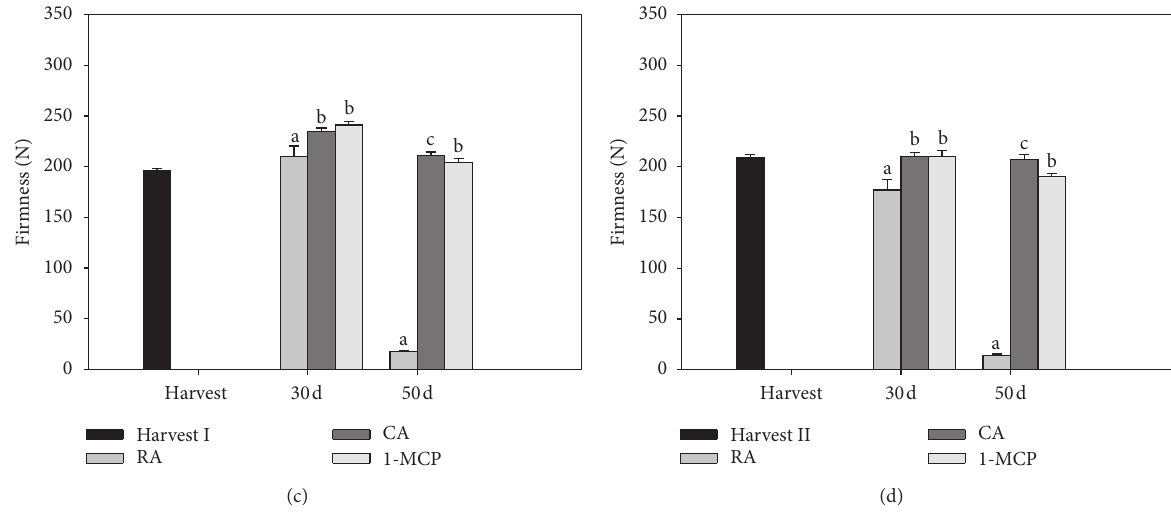
Figure 2: Flesh firmness immediately after storage at 5 ° C for 30 and 50 days. Each value is the mean of thirty-five fruits for treatment that was individually measured +/ − standard errors. (a, c) Harvest I. (b, d) Harvest II. RA: regular air. CA: controlled atmospheres (4% O 2 and 6% CO 2 ). Different letters within each storage period represent significant differences at P ≤ 0.05 as determined by the LSD test. d: